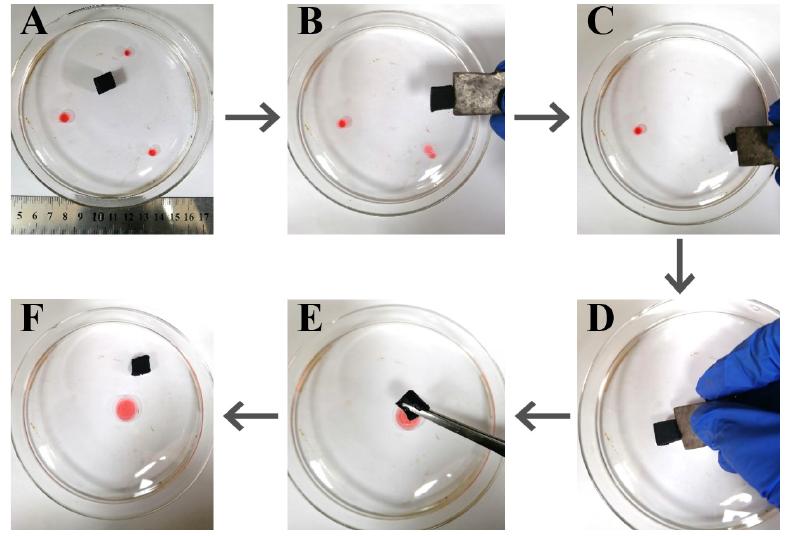
Figure 9. Magnetically guided cleanup of three chloroform droplets from water by using the m- AS/Kaolin@MS: On the way to the first droplet ( A ); cleaning the first droplet ( B ); cleaning the second droplet ( C ); cleaning the third droplet ( D ); squeezing out the oil using a tweezer ( E ); and recovered oil and recycled sponge ( F ).